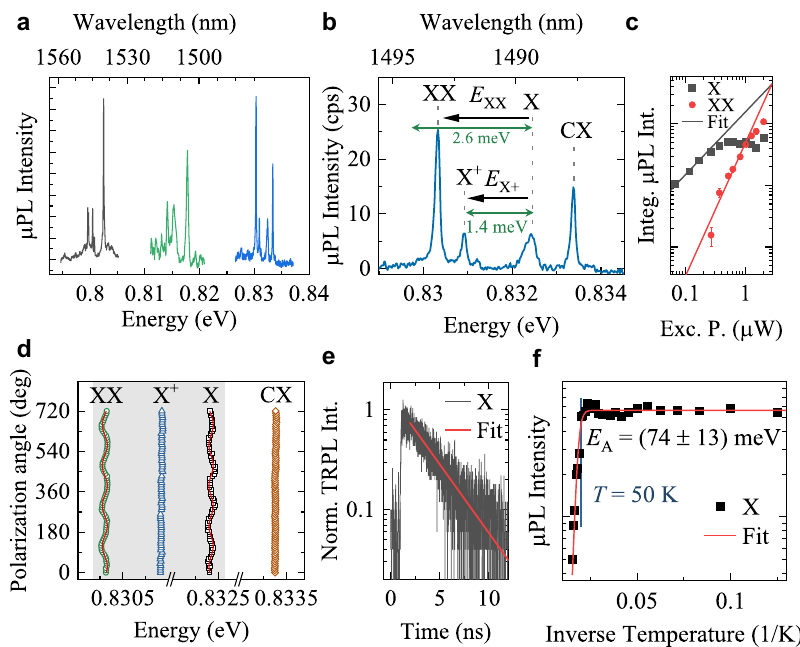
Figure 5: Single QD emission. (a) Exemplary high-resolution low-temper- ature ( T = 4.2 K) μ PL spectra measured in three different mesas containing QDs. (b) μ PLspectrumofanindividualQDwithidenti- fiedexcitoniccomplexes(exciton,X,positive trion, X + , and biexciton, XX), as well as a trion line from a neighboring QD (CX). The corresponding calculated binding energies for trion and biexciton are written and shown with green arrows (see QD2 in Table 1). (c) Integrated μ PL intensity for XX and X lines with fit lines. (d) Polarization-resolved μ PL for the lines shown in panel (b). (e) Time- resolved photoluminescence for the X line. (f) Temperature dependence of the X line μ PL intensity with the Arrhenius fit